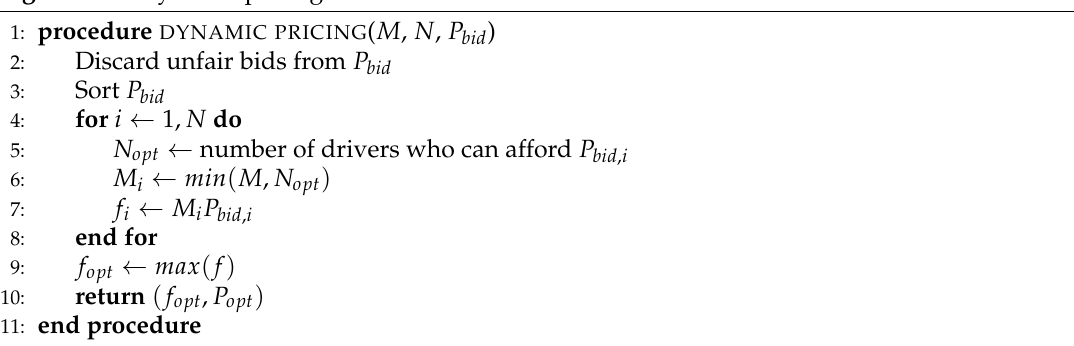
Algorithm 1 Dynamic